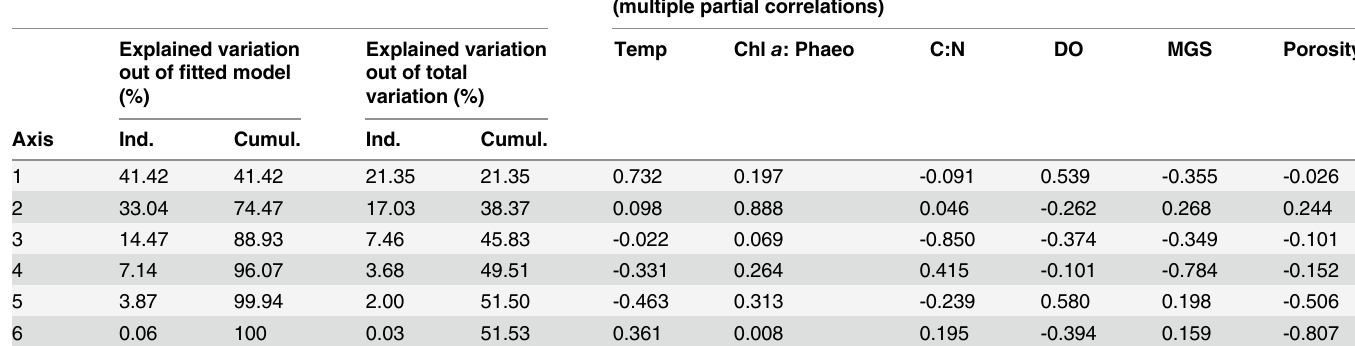
Table 4. Percent variation explained by individual axes and relationships between dbRDA coordinate axes and orthonormal variables from Dis- tance-based linear model (DistLM) of benthic fluxes against environmental drivers measured in the Salish Sea and NE Pacific in May/July 2011, and September 2013. Variation explained by individual axes (%)